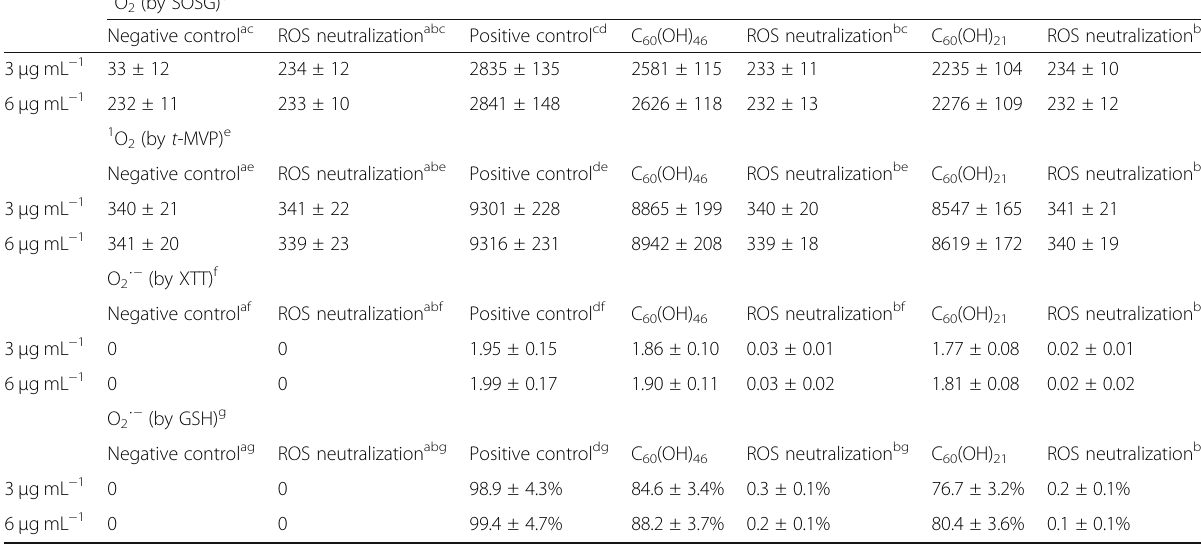
Table 2 The amount of ROS generated [23, 29, 33 – 35, 49 – 55] from by a TPE (211.2 nJ pixel − 1 , 800 scans; Ex, 760 nm) to water- soluble fullerenol-treated E coli. (3 or 6 μ g mL − 1 ) was conducted in the dark and monitored. Data are means ± SD ( n =